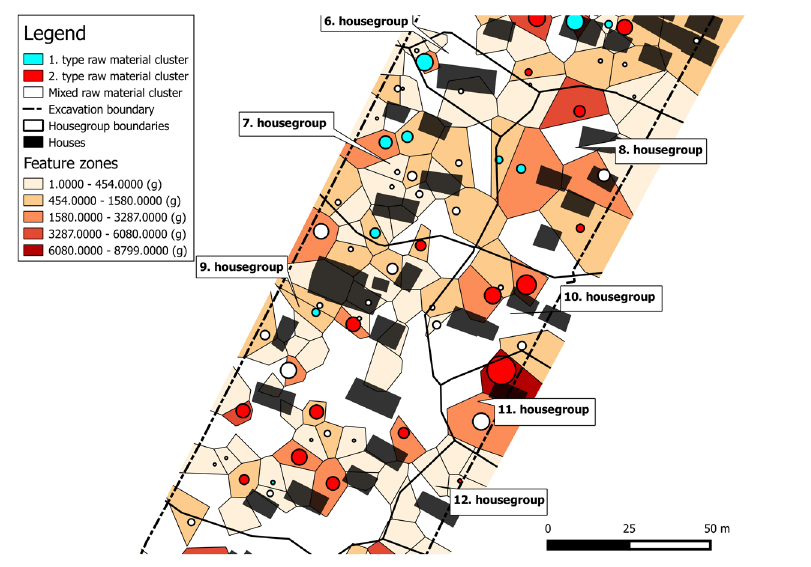
Figure 18: Houses, house groups, and activity zones in the middle section of the horizontal